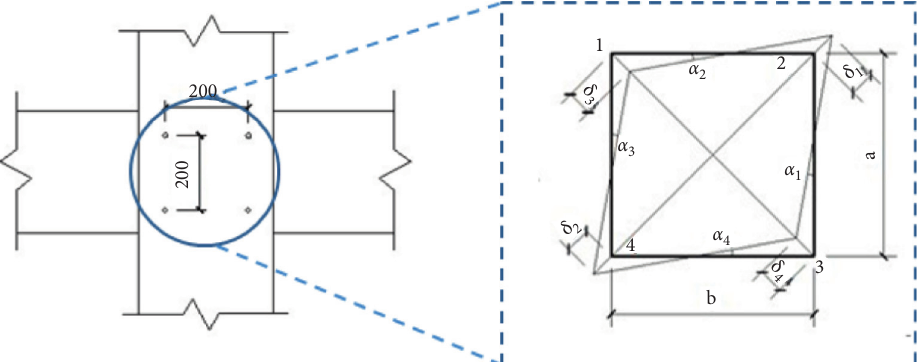
Figure 12: Measure of joint cores shearing deformation.